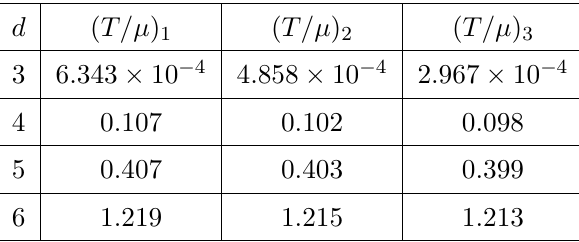
Table 3. For the strip in AdS-RN with d < d crit (cid:25) 6 : 7, as ( T=(cid:22) ) decreases, at ( T=(cid:22) ) 1 a local minimum and maximum appear in (cid:27)=s as a function of LT , at ( T=(cid:22) ) 2 < ( T=(cid:22) ) 1 the local maximum becomes a global maximum, but a local minimum remains, and (cid:27)=s < 1 for all LT , and then at ( T=(cid:22) ) 3 < ( T=(cid:22) ) 2 the global maximum rises above one, and the transition occurs to (cid:27)=s ! 1 + as LT ! 1